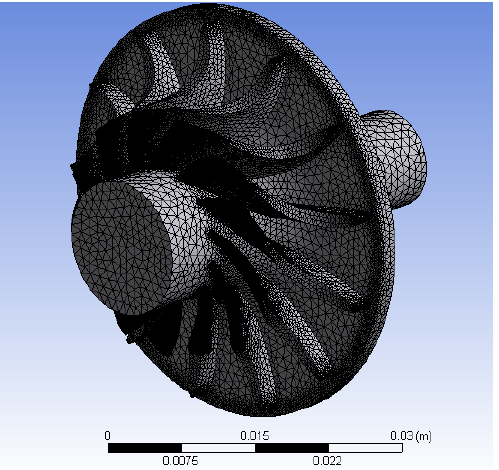
Figure 13. Example of impeller mesh.